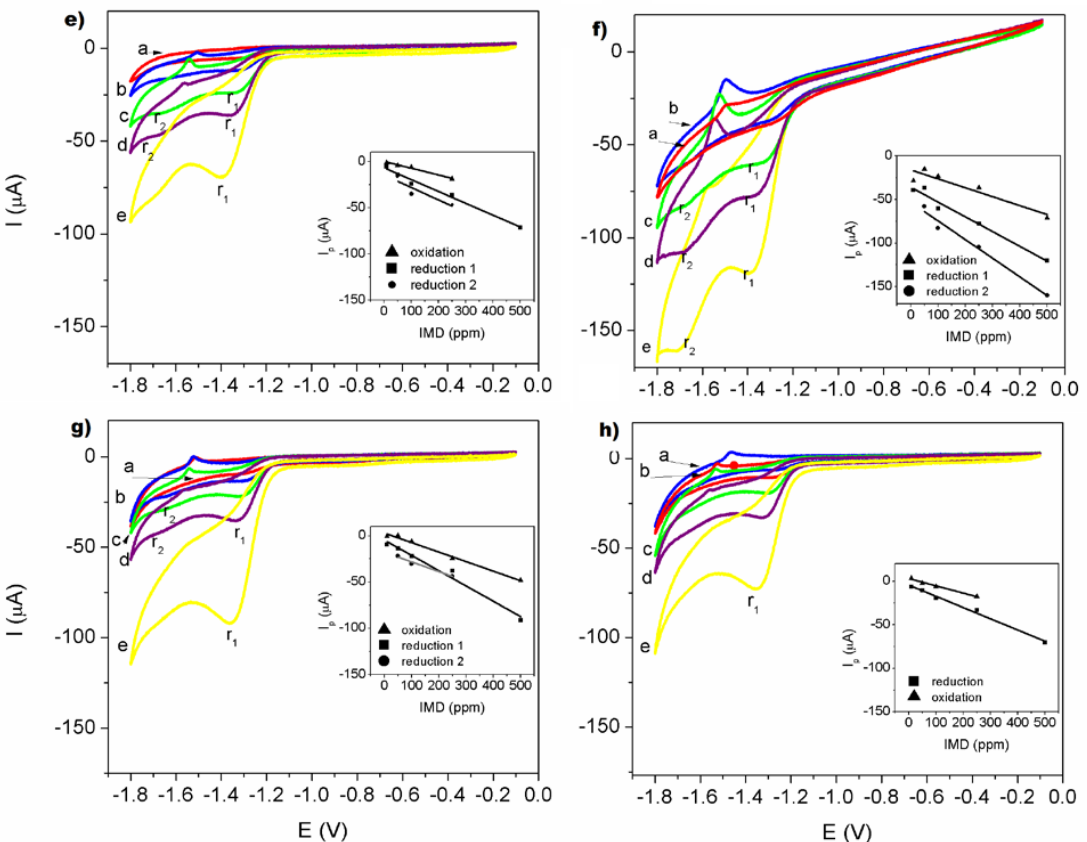
Figure 7. Cyclic voltammograms obtained for IMD on electrodes: ( a ) GCE; ( b ) GCE modified by CS; ( c ) GCE modified by CS-TiO 2 film with 10 wt.% of NPs; ( d ) GCE modified by CS-TiO 2 film with 20 wt.% of NPs; ( e ) GCE modified by CS–TiO 2 film with 30 wt.% of NPs; ( f ) GCE modified by CS-TiO 2 film with 40 wt.% of NPs; ( g ) GCE modified by CS–TiO 2 film with 50 wt.% of NPs; ( h ) GCE modified by CS-TiO 2 film with 60 wt.% of NPs. Measurements were carried out at 150 mVs − 1 in 0.05 M Na 2 SO 4 as supporting electrolyte, pH = 7. Each cycle corresponding to the different concentrations: a-10, b-50, c-100, d-250, e-500 ppm. Inserts show relationship between peak current of reduction and/or oxidation vs IMD